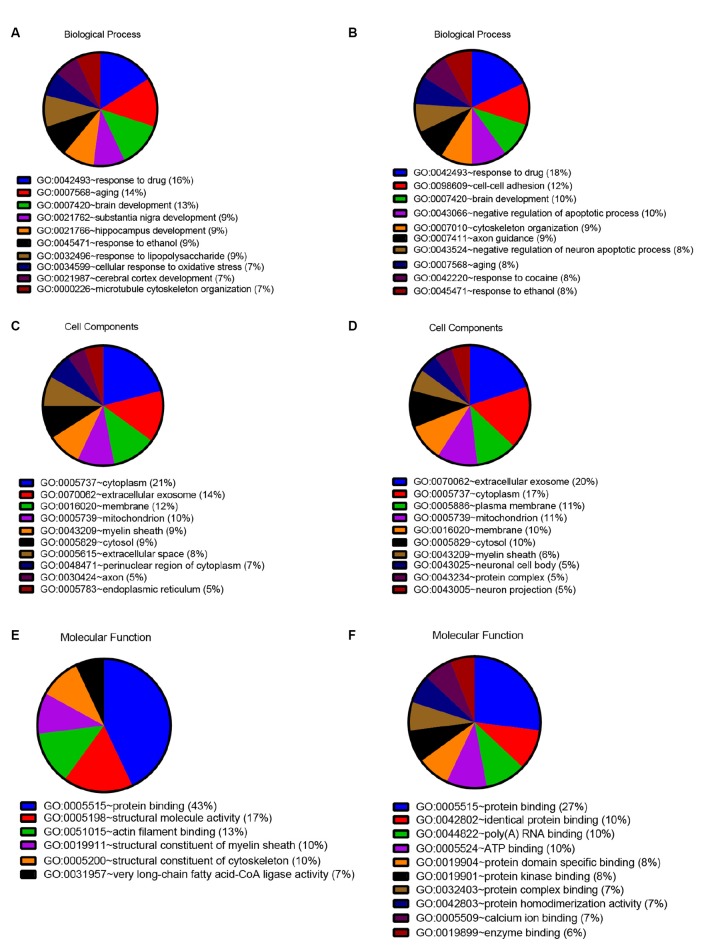
Quantitative GO annotation analysis in terms of upregulated and downregulated DEPs. GO analysis showed that the acute IS proteome mainly involves protein binding and response to drug for both upregulated and downregulated DEPs, while the cell component analysis showed the dominance of cytoplasm for upregulated DEPs and extracellular exosome for downregulated DEPs. (A) GO annotation by David summarizing biological process for upregulated DEPs. (B) GO annotation by David summarizing biological process for downregulated DEPs. (C) GO annotation by David summarizing cellular components for upregulated DEPs. (D) GO annotation by David summarizing cellular components for downregulated DEPs. (E) GO annotation summary according to molecular function for upregulated DEPs. (F) GO annotation summary according to molecular function for downregulated DEPs.